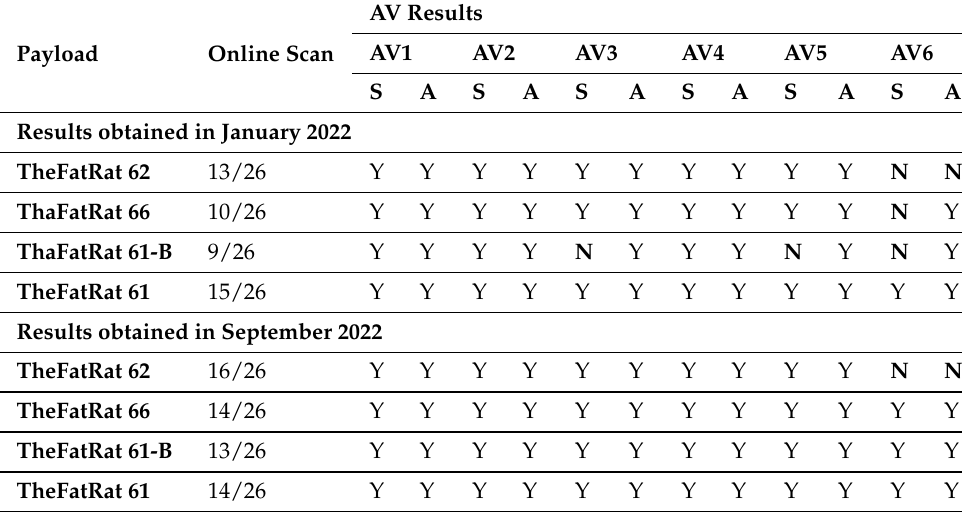
Table 2. TheFatRat